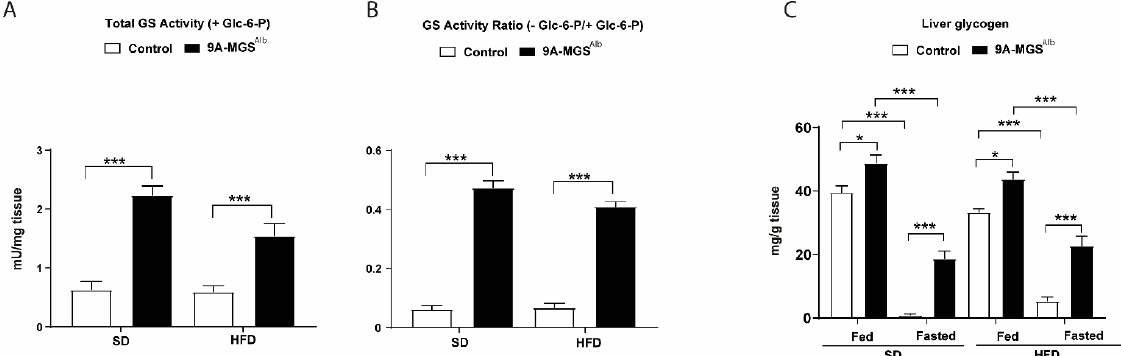
Figure 1. Characterization of 9A-MGS Alb mice fed a standard diet (SD) or a high-fat diet (HFD). Control and 9A-MGS Alb mice aged 6 weeks were fed an SD or HFD for 16 weeks. Fed and 16 h fasted mice were killed. ( A ) Liver Total GS activity under fed conditions. ( B ) Liver GS activity expressed as the ratio of (-) Glc-6-P/(+) Glc-6-P under fed conditions. ( C ) Liver glycogen content under fed conditions or a 16 h fast. Data are mean ± SEM. n = 6–10/group. * p < 0.05, *** p < 0.001. We also determined the daily energy expenditure (EE) during the dark and light phases in the two genotypes. When fed an SD or HFD, control and 9A-MGS Alb mice had similar EEs (Figure 3A). No significant difference in locomotor activity was observed be- tween the two genotypes (Figure 3B and 3C). In animals on the SD, there were no differ-